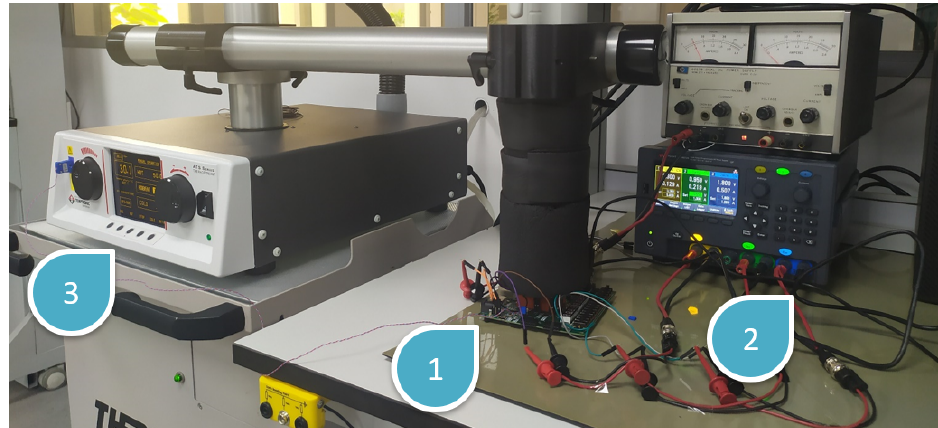
Figure 15. PUF characterization setup for voltage and temperature variations. 1. Development Board.